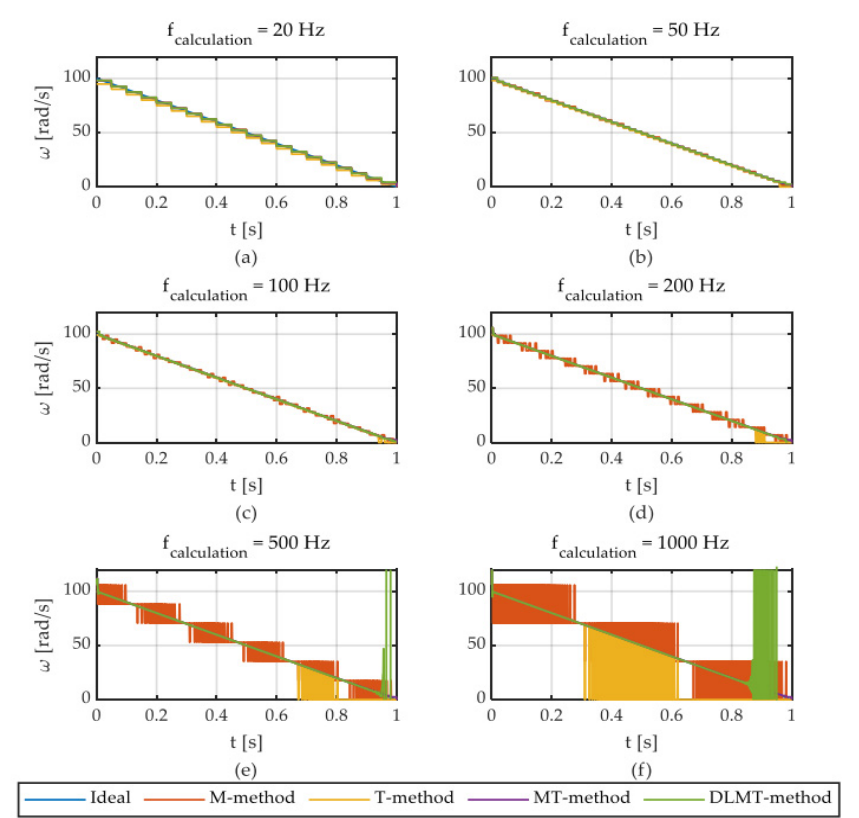
Figure 5. Speed estimation by M, T, MT, and DLMT algorithms for different calculation frequencies [15] .